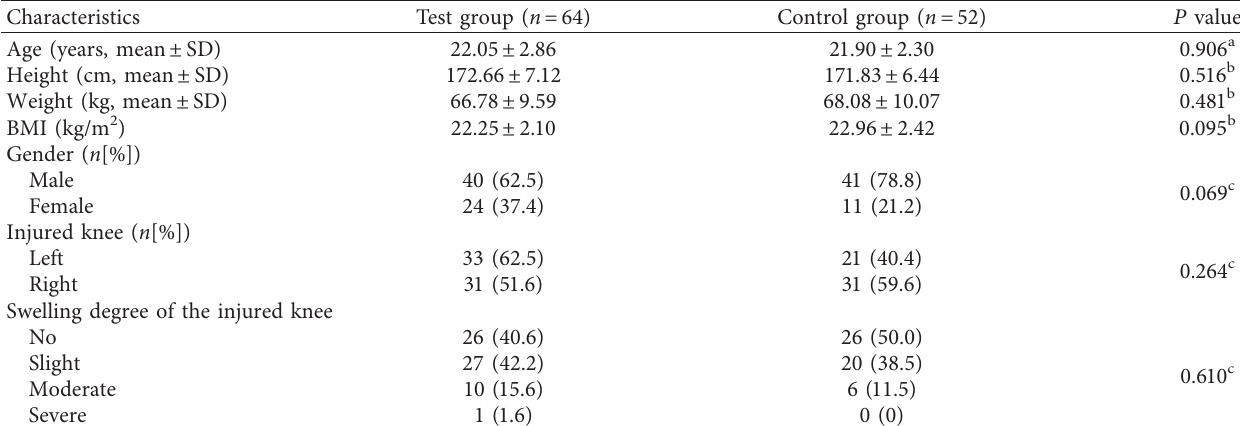
Table 2: Demographic characteristics of both groups ( N � 116).